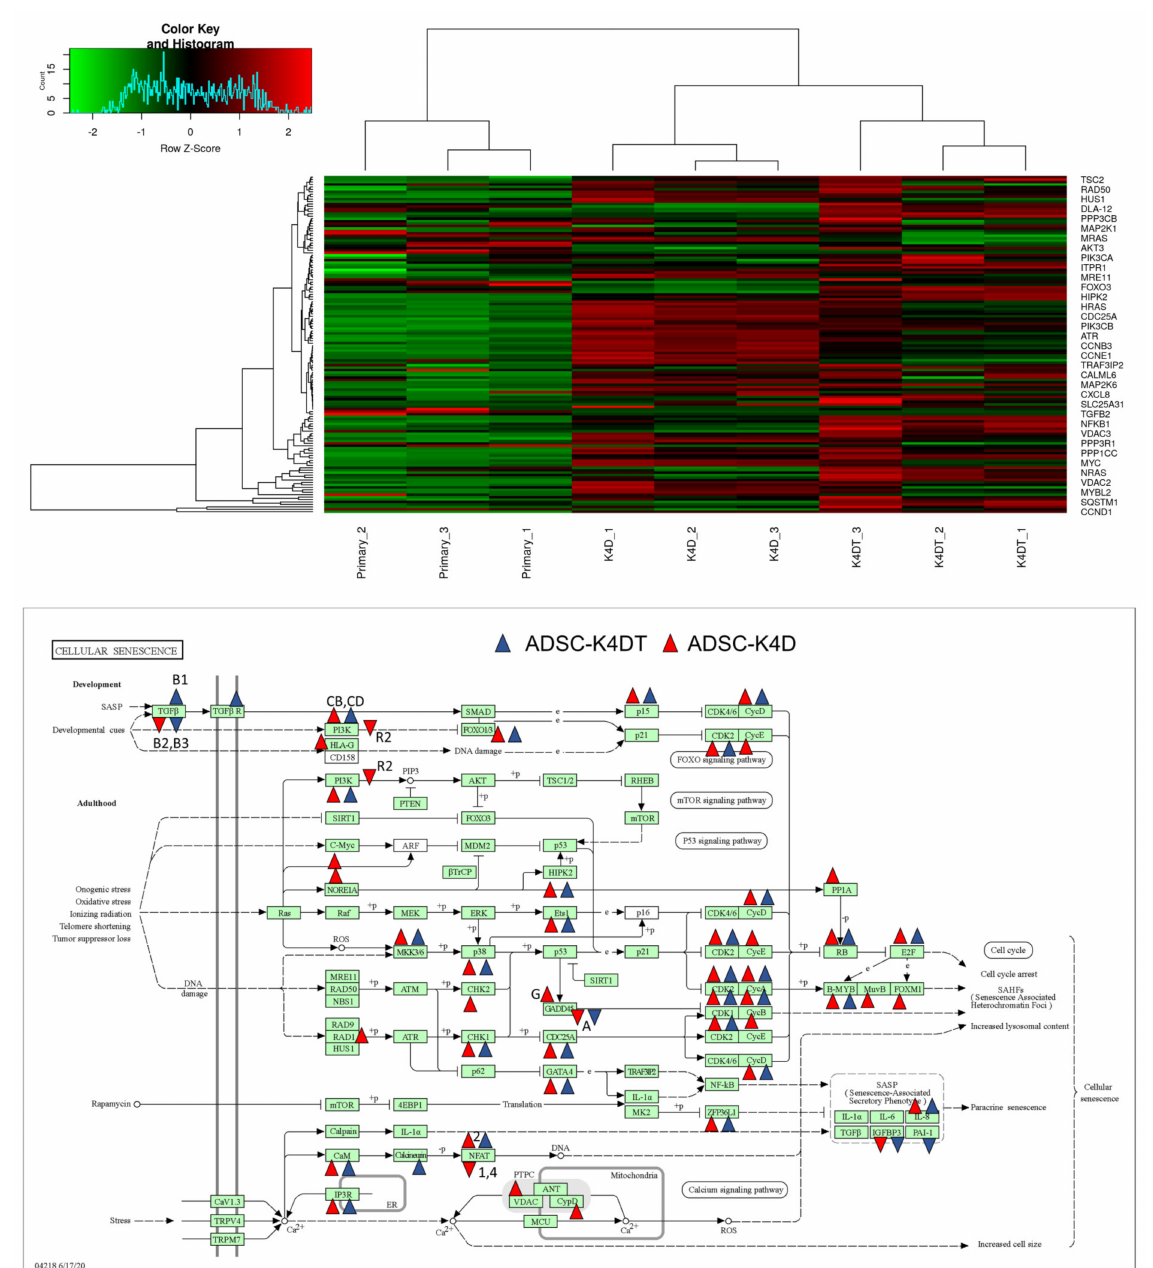
Figure 12. RNA-seq analysis of the cell senescence-related genes. Upper panel: Heatmap of the genes listed in the cell senescence pathways in the primary ADSCs, and the ADSC-K4DT and ADSC-K4D cells. Red indicates high expression, and green indicates low expression. Lower panel: Summary of the up- and down-regulated genes among the KEGG cell senescence-related genes. Arrowheads indicate the up- or down-regulated genes in the ADSC-K4DT and ADSC-K4D cells. The genes with an adjusted p -value of < 0.05 and fold change of >2 or <0.5 compared with the primary ADSCs were